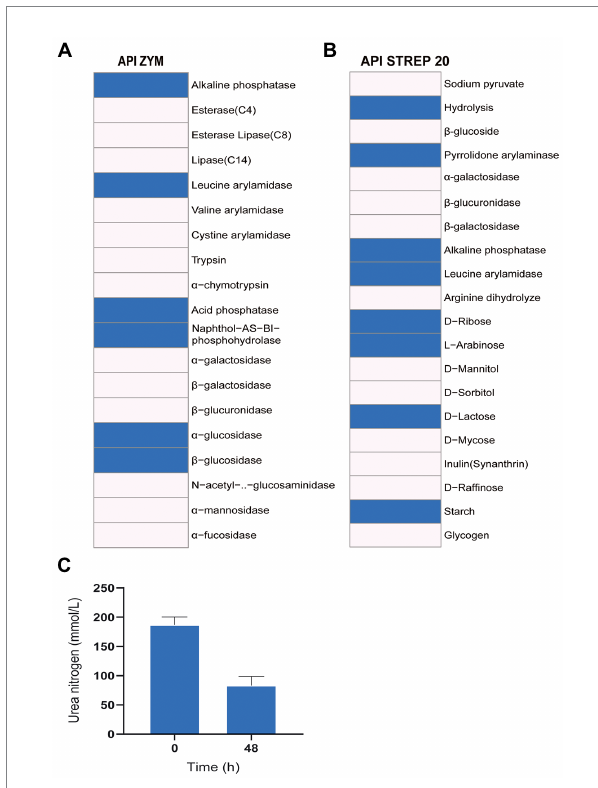
FIGURE 6 The enzyme activity and utilization of carbohydrates and urea. (A) Results of API ZYM, indicating 19 kinds of enzyme activities. The blue presents positive, the blank presents negative. (B) The results of API STREP 20. The result indicates enzyme activities and utilization of carbohydrates. The blue presents positive, the blank presents negative. (C) Change of urea nitrogen with the increased culturing